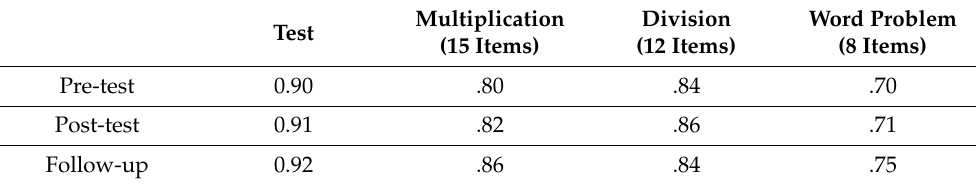
Table 2. Reliability indices for pre- post- and follow-up test results.